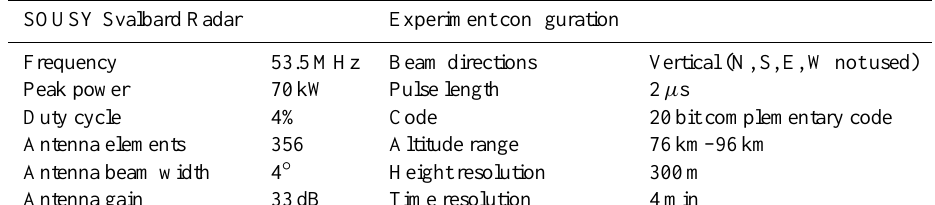
Table 1. Technical radar parameters and experiment configuration.